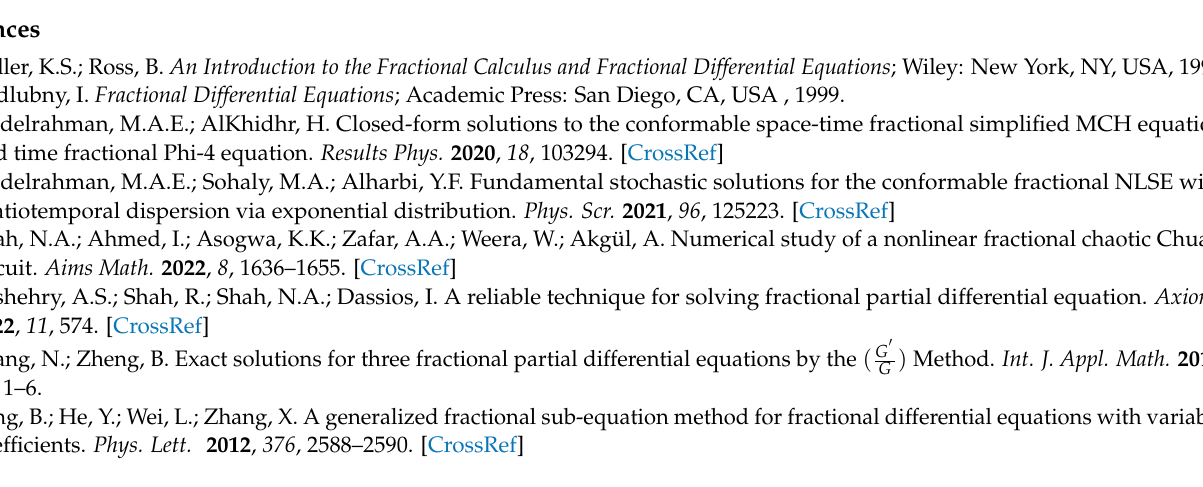
Figure 10. The first and second moments for the random solution ˜ sq random variable and − 2 ≤ t , x ≤